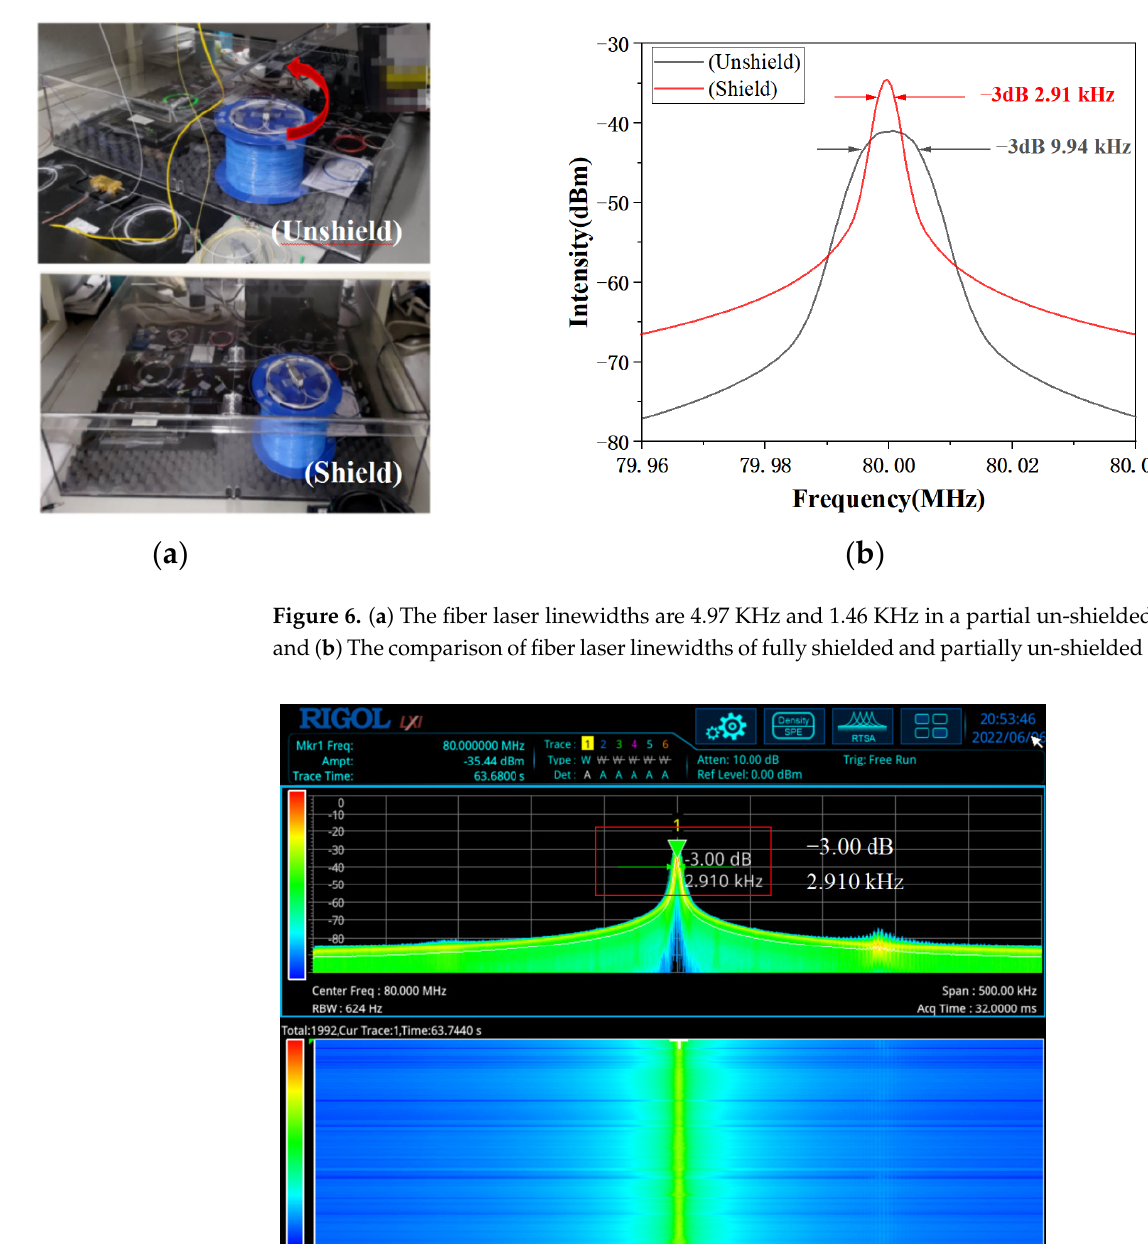
Figure 7. The linewidth stable measurement of a fiber laser.